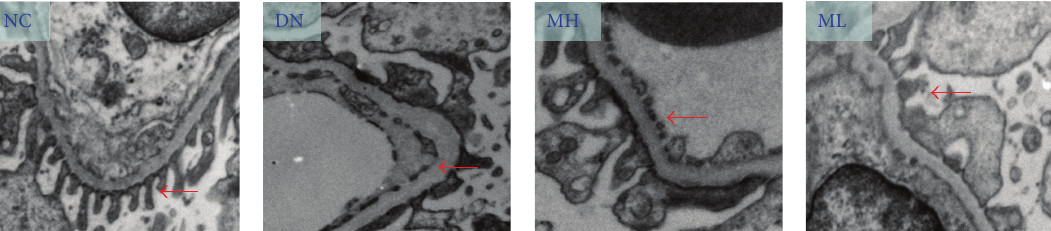
Figure 2: Transmission electron microscopy of the kidney tissue ( × 10,000). Hydropic endothelial cells and podocytes, endothelial pore broadening, irregular thickening and decrease in the electronic density of the basement membrane, and partial foot process fusion were visualized in the experimental groups (red arrow), especially in the diabetic nephropathy group, but were found to be recovered in the MH